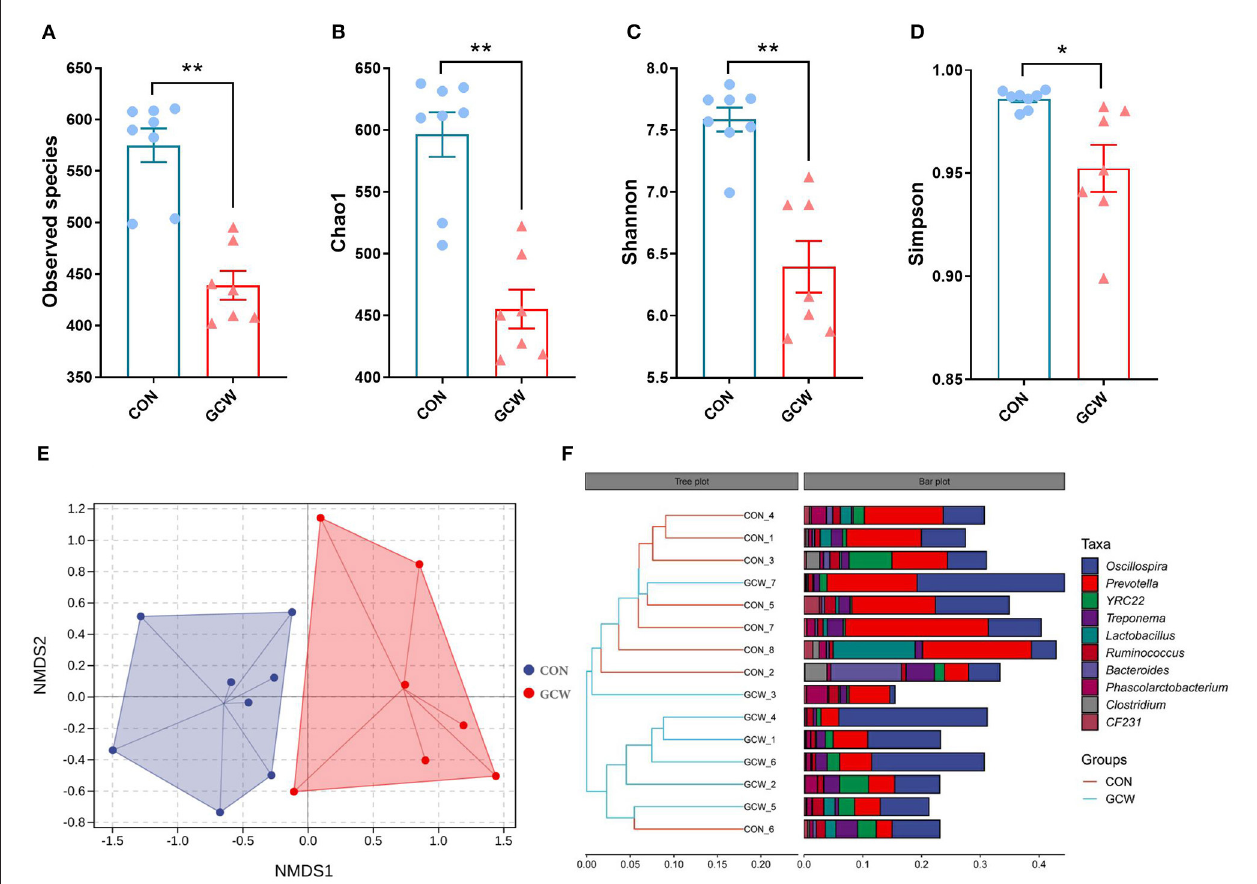
FIGURE 1 | Alpha and beta diversity of gut microbiota. The number of Observed species (A) , Chao 1 (B) , Shannon (C) , and Simpson index (D) between control ( n = 8) and GCW ( n = 7) groups. (E) Non-metric multidimensional scaling (NMDS) plot. (F) Dendrogram of hierarchical clustering analysis. Data are presented as means ± SEM. * p < 0.05, ** p <